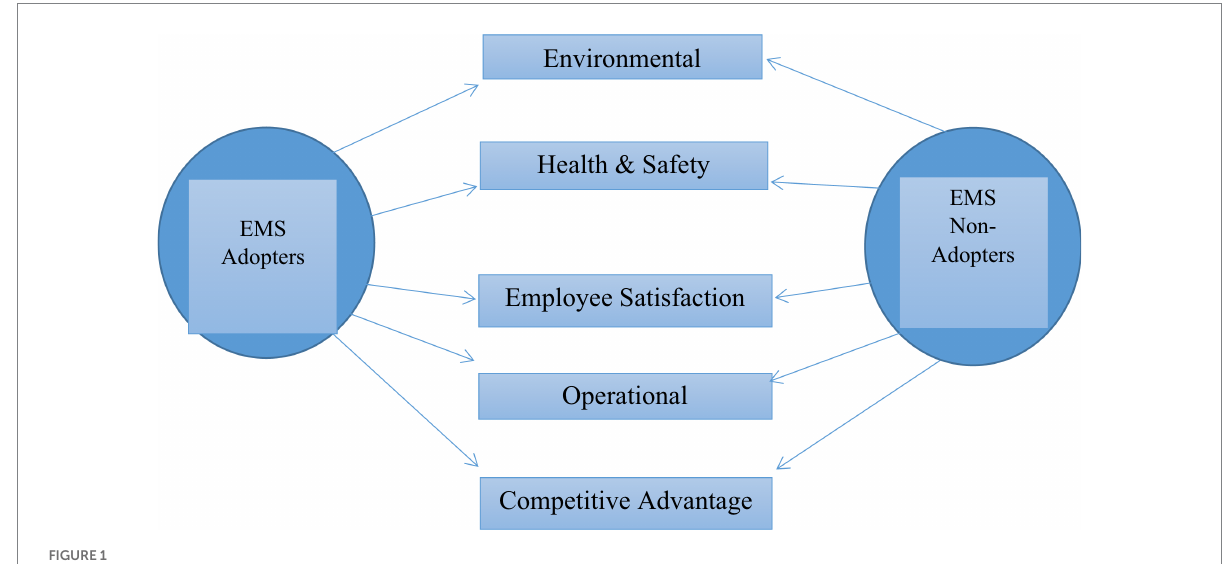
FIGURE 1 Theoretical